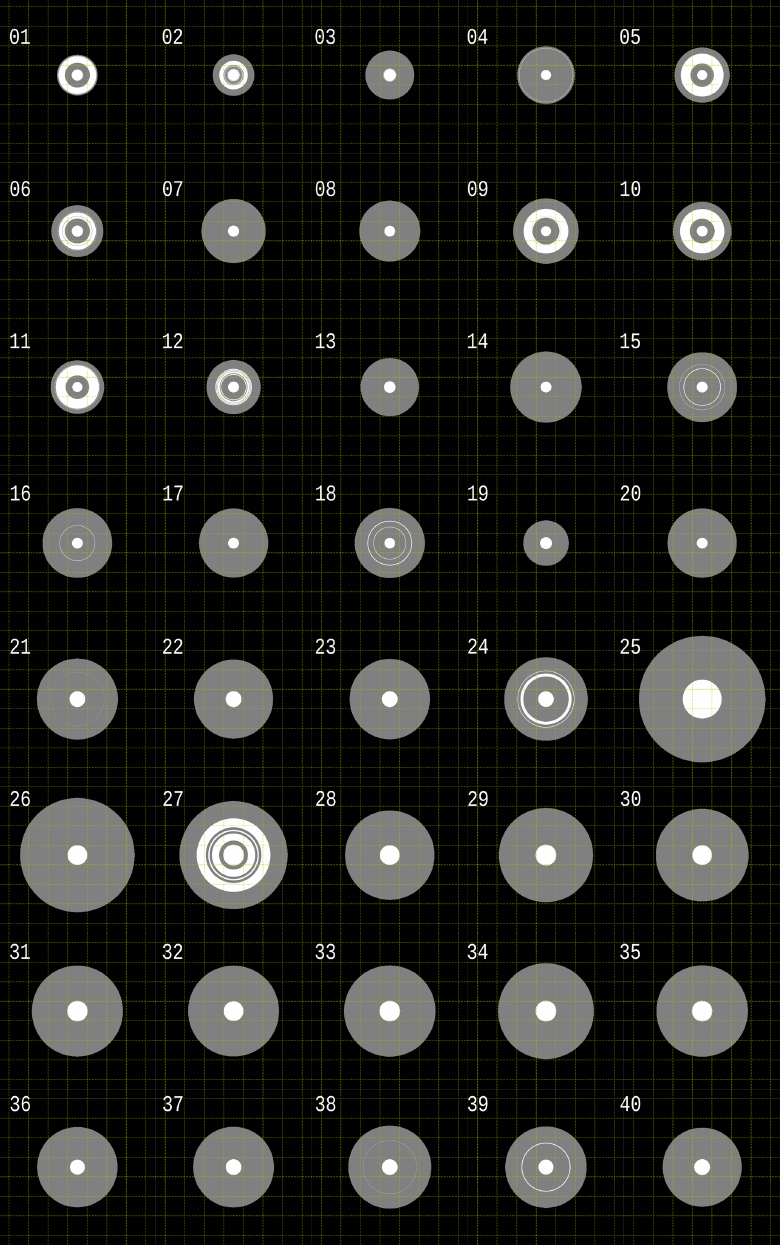
Figure 9. Circular hailstone cross sections generated from the umax31 storm of Kumjian and Lombardo (2020). White-shaded regions represents opaque dry-growth layers, and grey-shaded regions indicate translucent wet-growth layers. Grid lines shown at a 1cm spacing starting from 0.5cm from the embryo